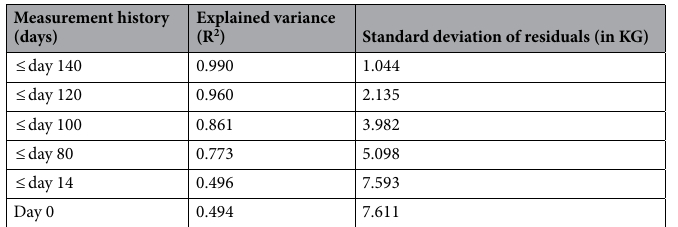
Table 2. Results of prediction models for weight at day 160 with decreasing amount of measurement history used. Covariates: breed code, farm of measurement, sex, season of birth.